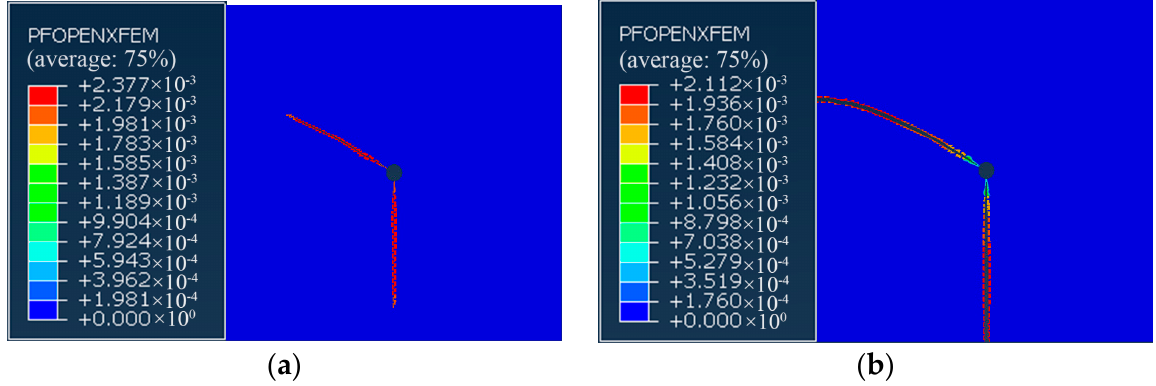
Figure 4. Cloud diagram of fracture width variation. ( a ) Step 674 moment; ( b ) Final moment.